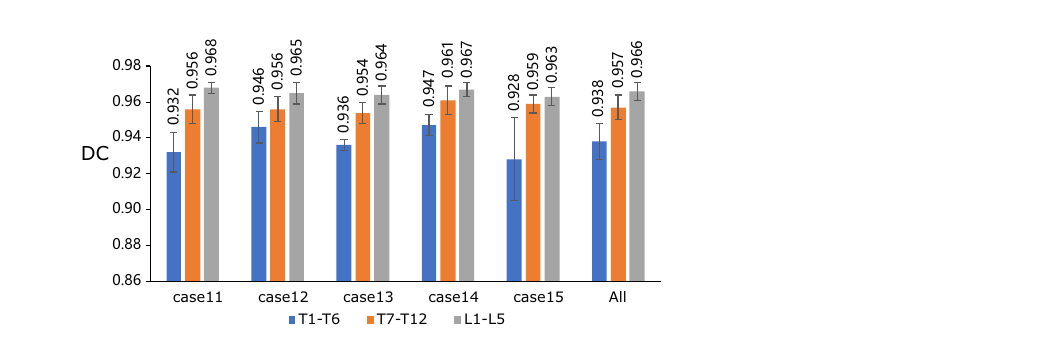
Figure 9. Evaluation on three groups: upper thoracic, lower thoracic and lumbar spine.